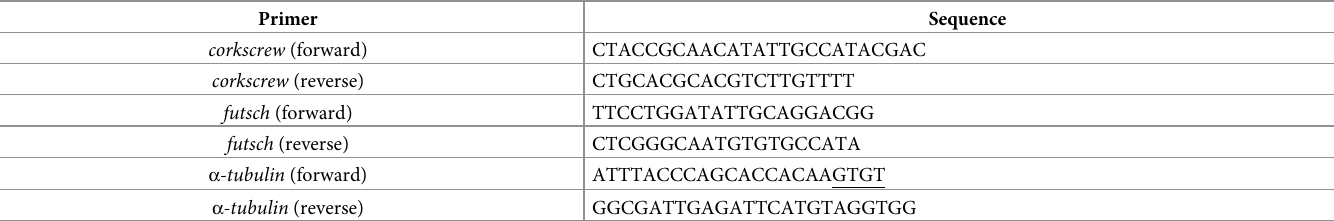
Table 2. Primers used for RNA immunoprecipitation. The length of PCR products is approximately 200